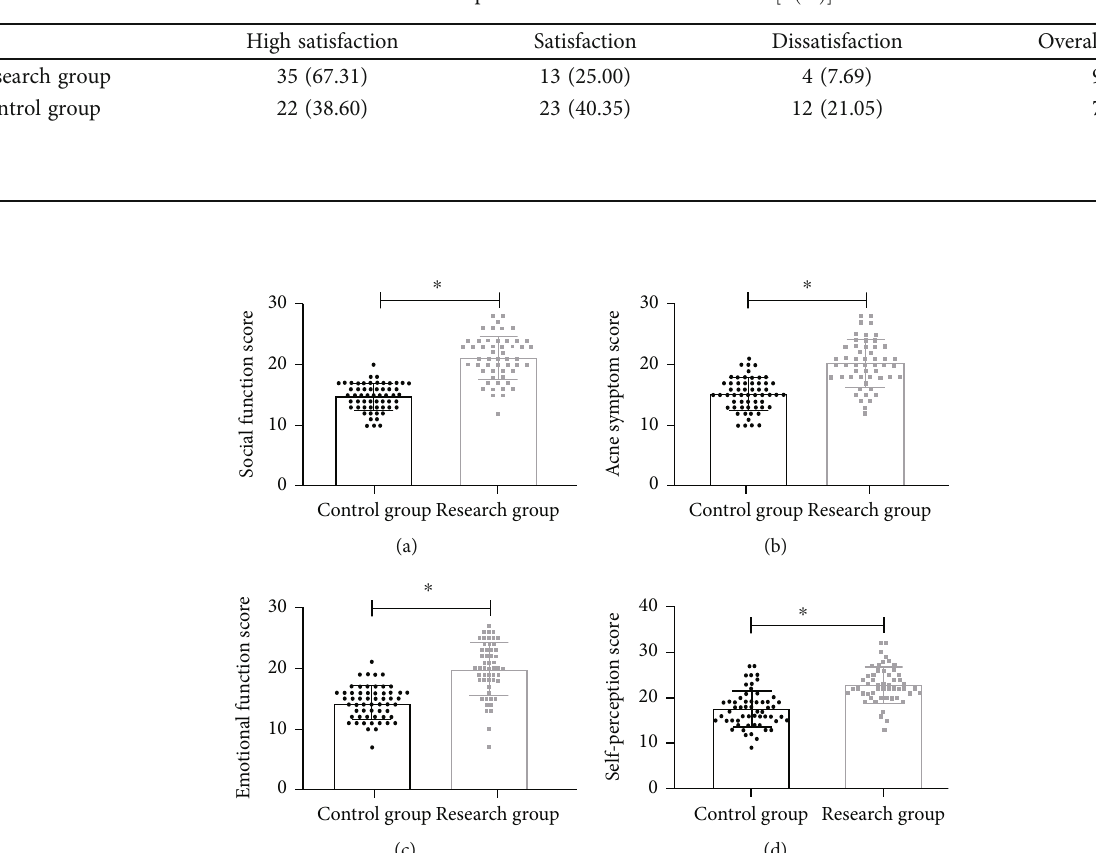
Figure 5: Comparison of psychological state. (a) SAS score before and after treatment. (b) SDS score before and after treatment. ∗ Di ff erence vs. the situation before treatment. # Di ff erence vs. the control group. SAS: self-rating anxiety scale; SDS: self-rating depression scale. Table 5: Comparison of treatment satisfaction ½ n ð % Þ(cid:2) .